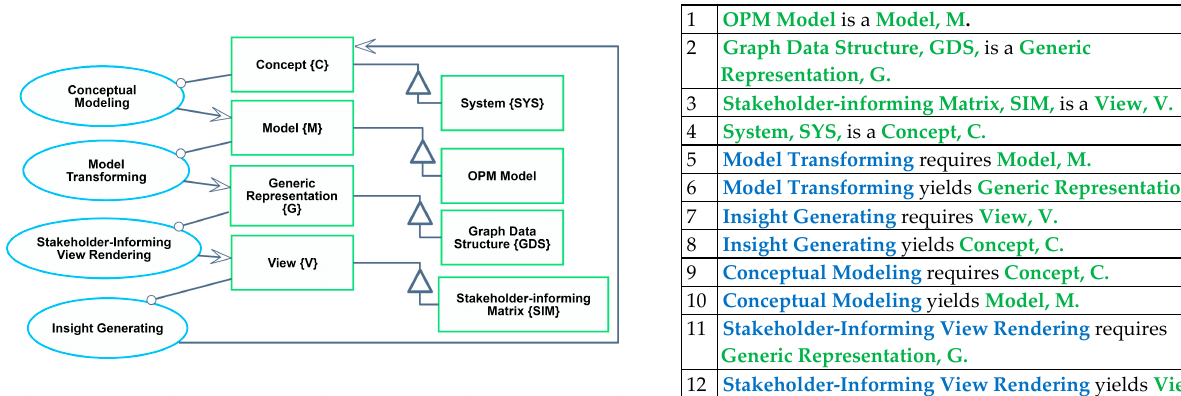
Figure 5. The CMGVC, as a cognitive–computational cycle of Conceptual Modeling, Model Transforming, Stakeholder- informing View Rendering, and Reasoning. The System, OPM Model, GDS, and SIM are specializations of the respective generic artifacts: Concept, Model, Generic Representation, and View.